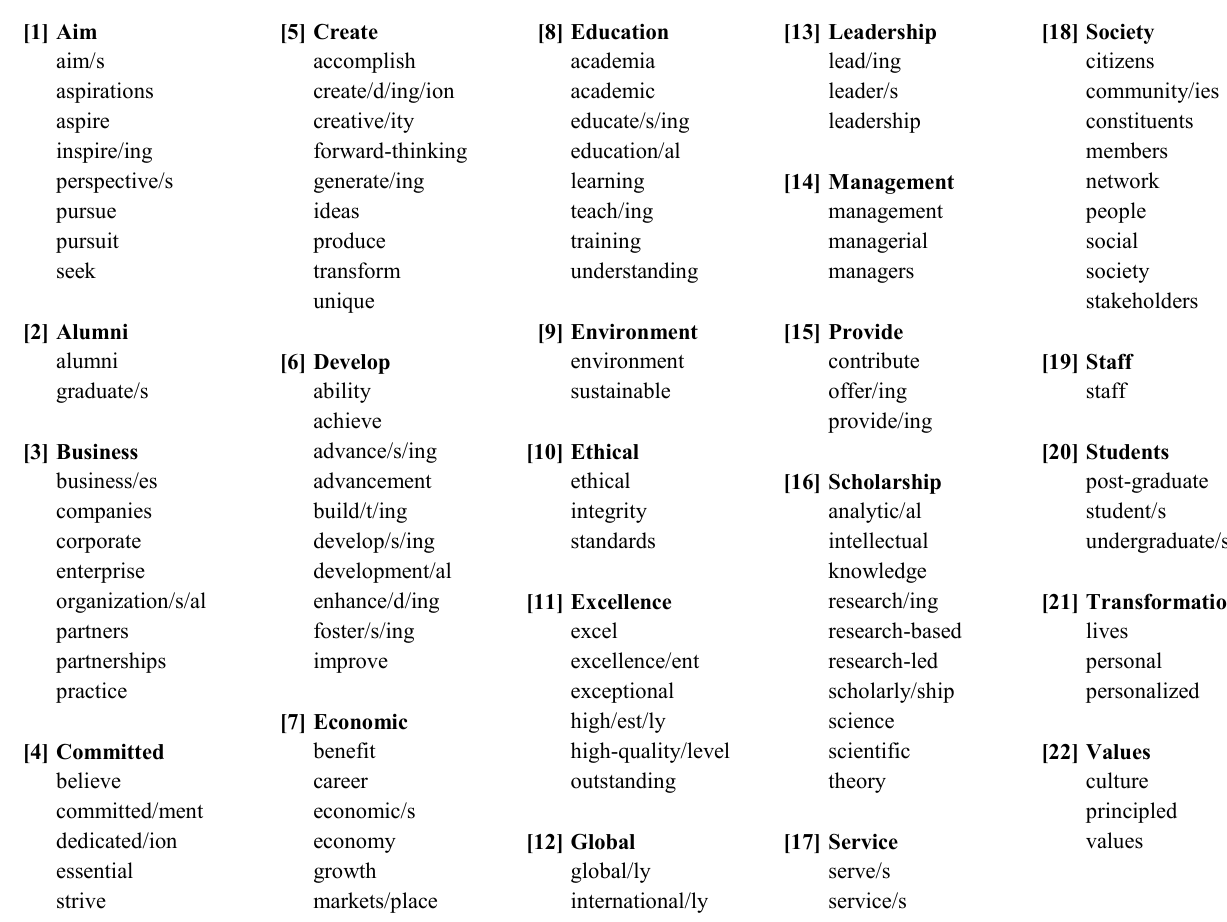
Table 2: Leximancer™ concept aggregation